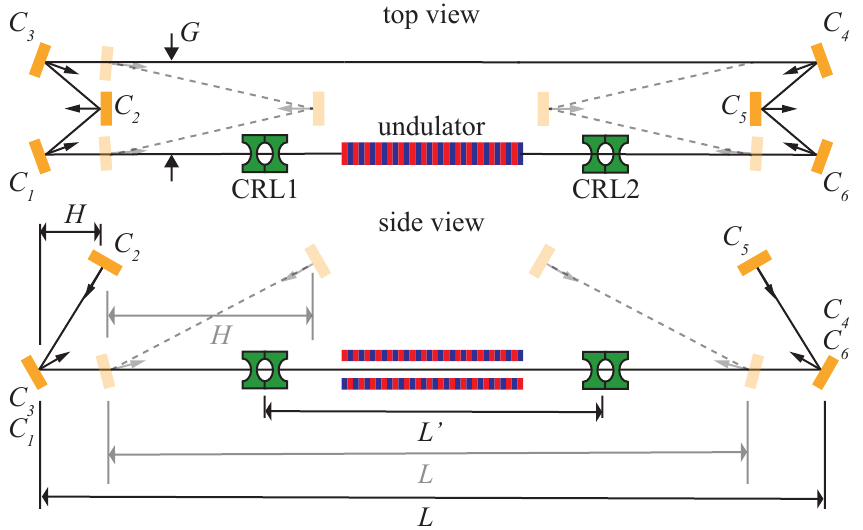
Figure 21. Schematic view of a 6-mirror ring resonator for an X-ray FEL oscillator using plane Bragg mirrors C 1 . . . C 6 and compound refractive lenses, CRL1 and CRL2 for focusing. After